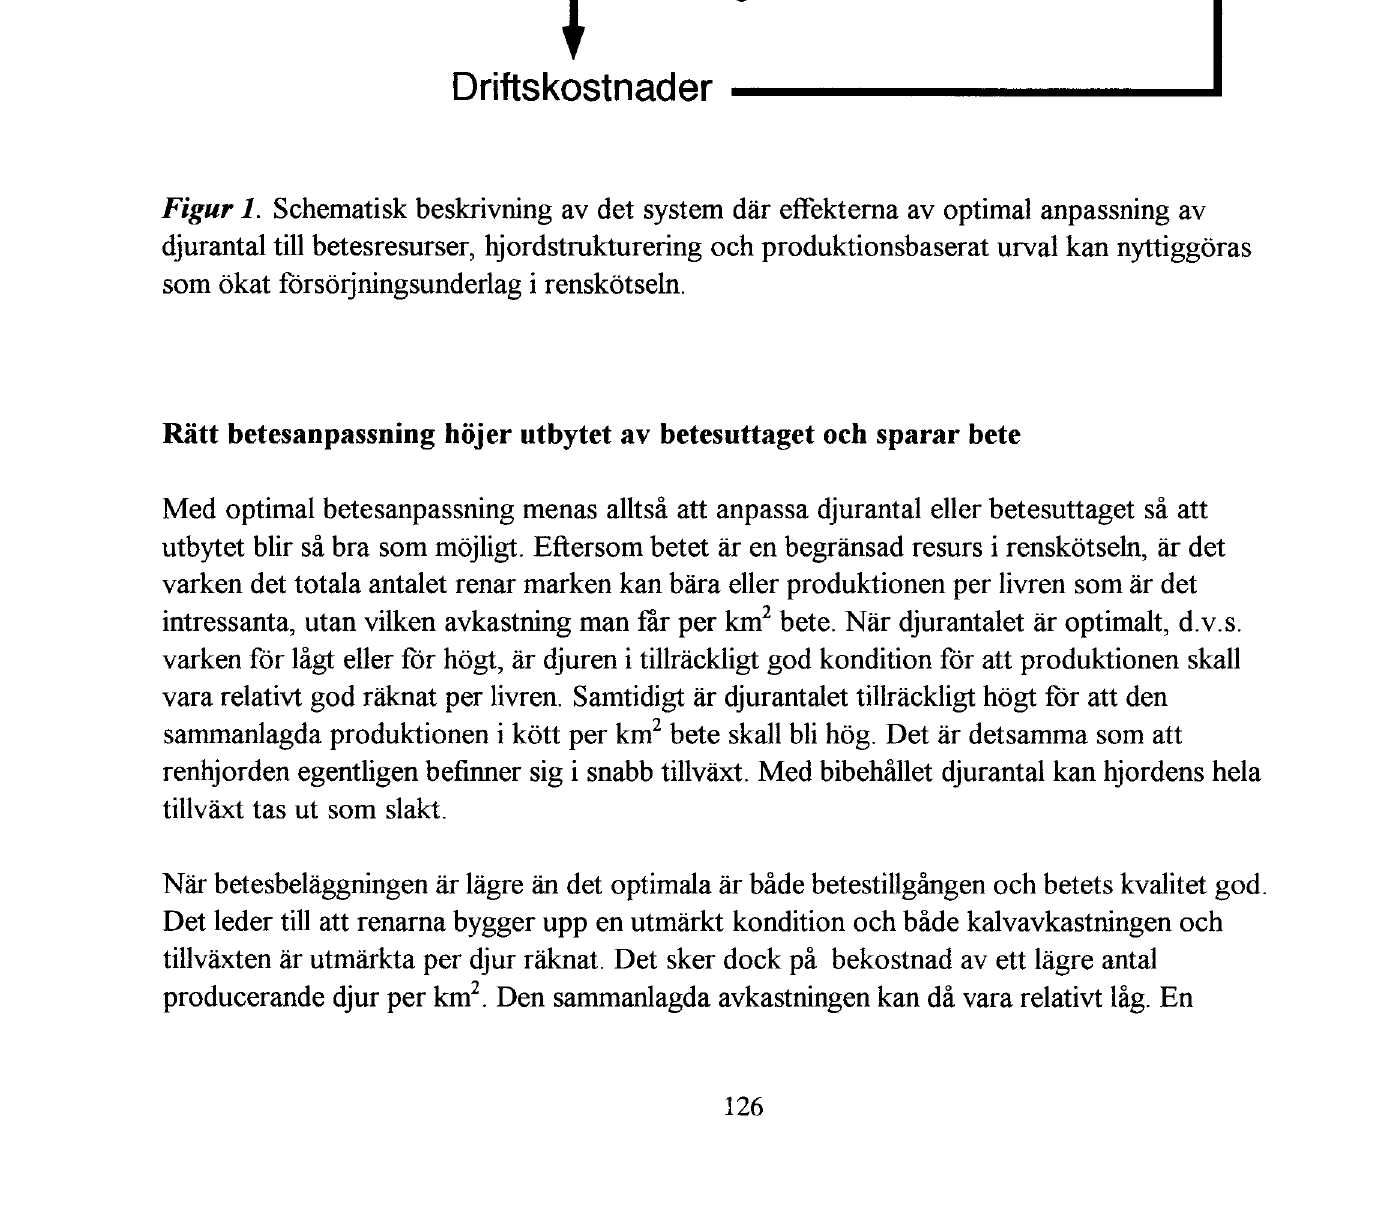
Figur 1. Schematisk beskrivning av det system dår effekt erna av optimal anpassning av djurantal till betesresurser, hjordstrukturering och produktionsbaserat urval kan nyttiggoras som okat fbrsorjningsunderlag i